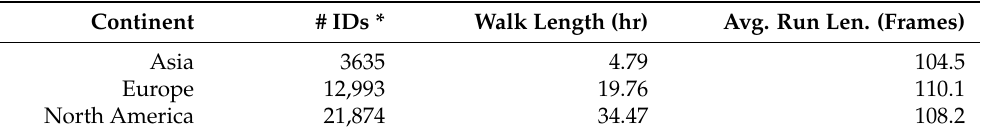
Table 1. Geographic locations from where we gathered skeleton sequences. We aimed for a multi- cultural representation of walking people. * Approximate number given by pose